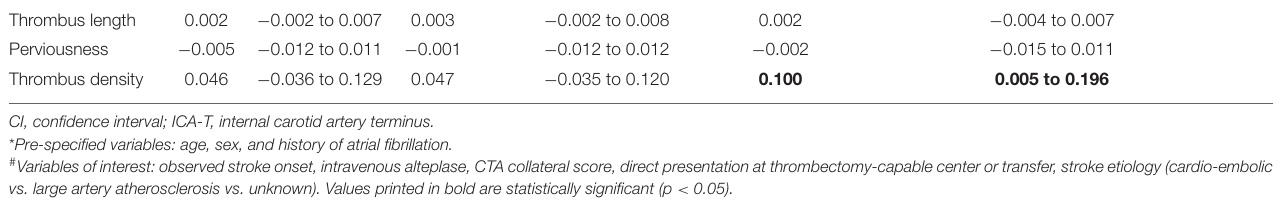
TABLE 2 | Beta coefficients of the effect of time from stroke onset to CT imaging (per 5min) on thrombus characteristics. Outcome variable Model 0 Model 1 Model 2 Unadjusted Adjusted for pre-specified variables* Adjusted for pre-specified variables* + variables of interest # β 95% CI β 95% CI β (95% CI) Thrombus length 0.002 − 0.002 to 0.007 0.003 − 0.004 to 0.007